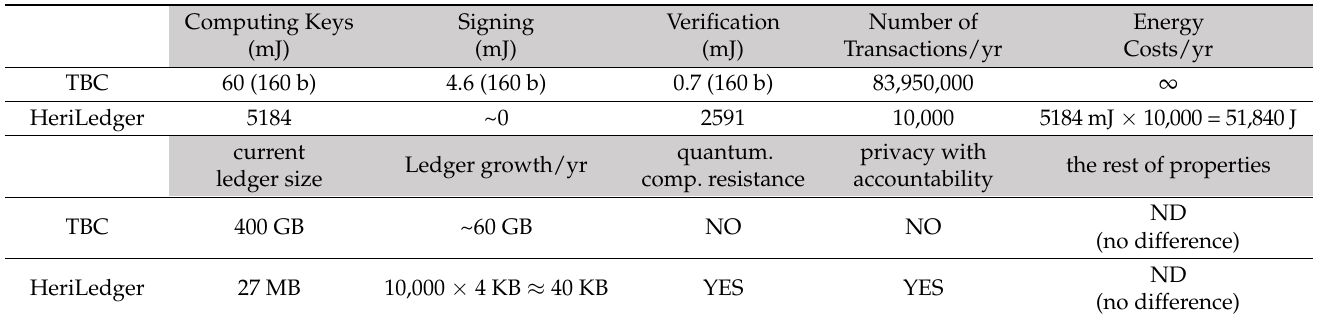
Table 2. Comparison of TBC and Heriledger (for a signature and its verification with ECC-160b one order of magnitude lower energy consumption is assumed than for